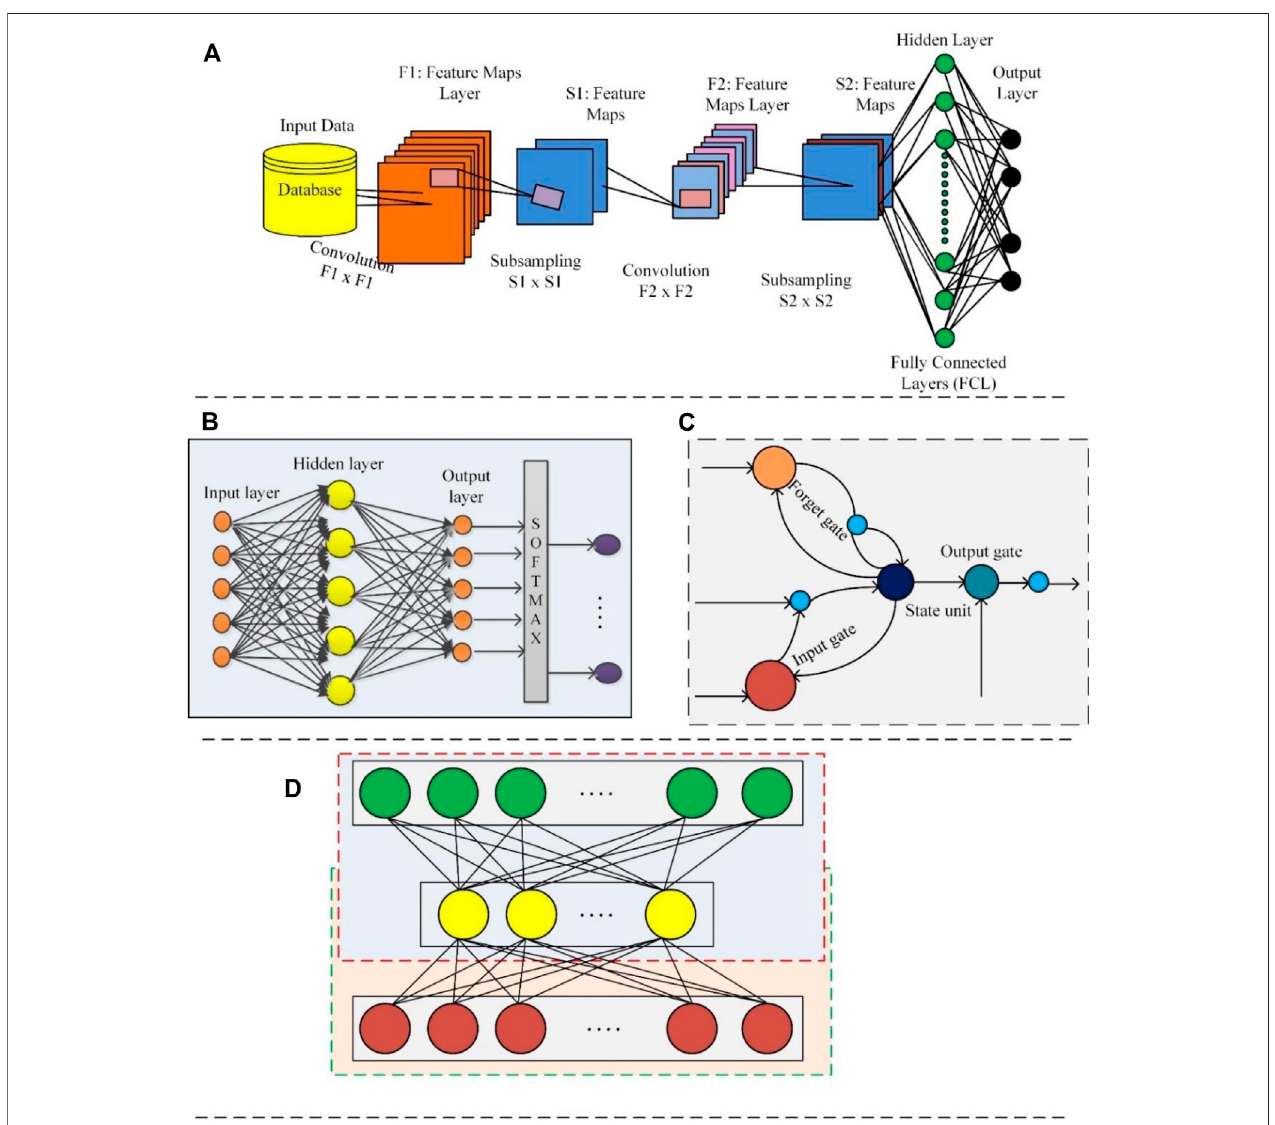
FIGURE 1 | Typical architectures of (A) CNN model, (B) DNN model, (C) LSTM, and (D) auto encoder.